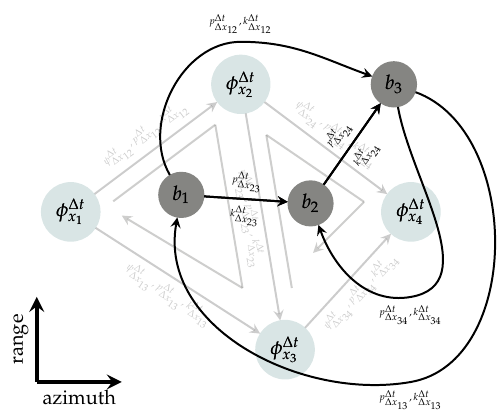
Figure 2. Dual graph of Figure 1. The constraints of the primal problem define the new nodes with node potential b . The arcs connect these nodes by cutting the arcs of the primal